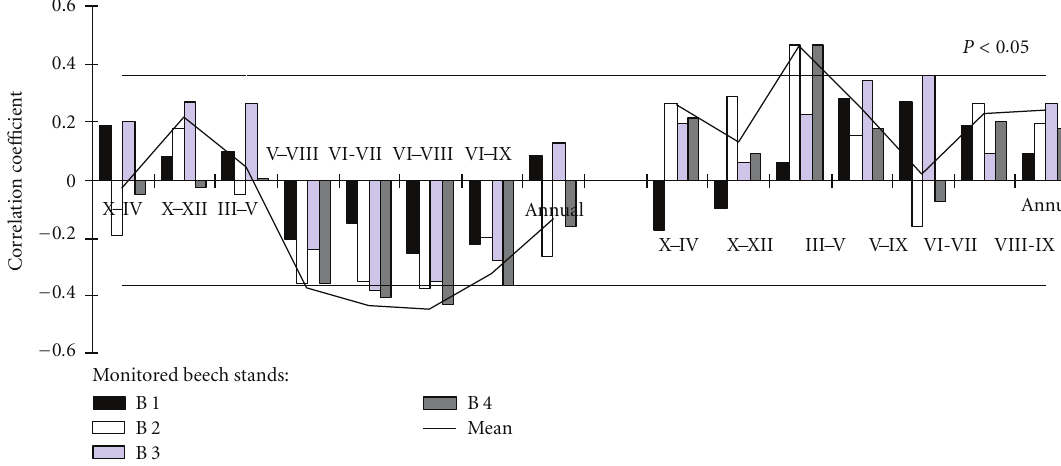
Figure 4: E ff ect of air temperature and precipitation amount on beech tree-ring indices in monitored stands over the 31 years period.